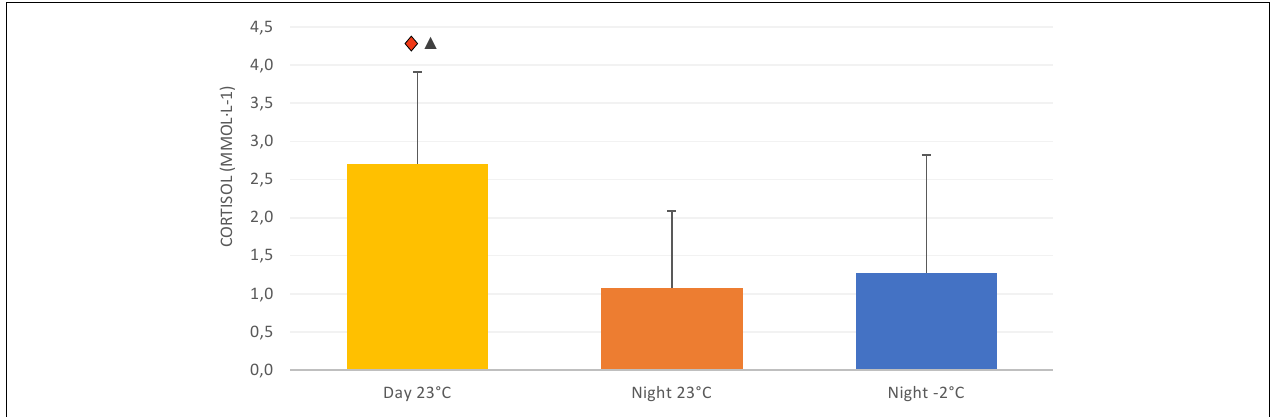
FIGURE 3 | Cortisol in saliva at 04:00 am and at 12:00 pm under all exposures. ( (cid:169) ) A significant difference between Day 23 ◦ C and Night 23 ◦ C and ( (cid:115) ) significant difference between Day 23 ◦ C and Night –2 ◦ C. Data are presented as means ± SD ( n = 11).